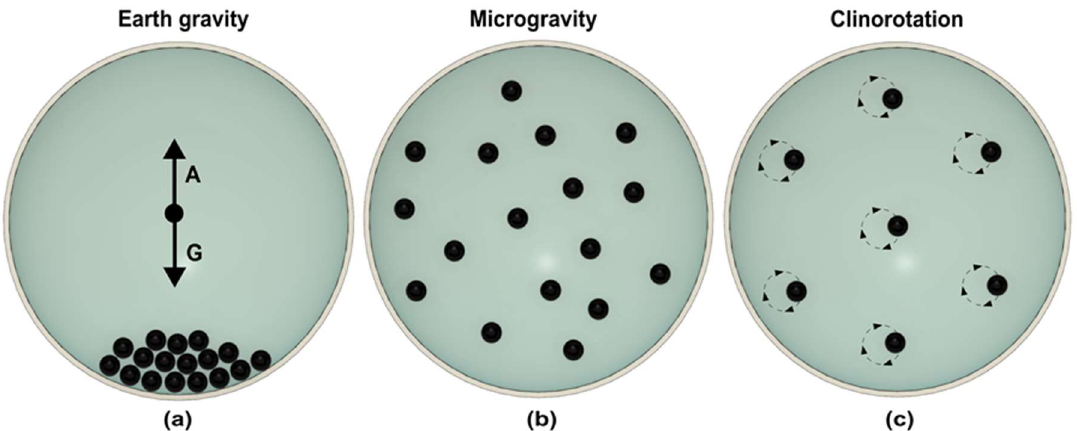
Figure 2. Schematic representation of fast rotating clinostat. ( a ) On earth, particles sediment in the sample holder. The downward gravity (G) and buoyancy (A) forces determine the particle’s position. ( b ) In microgravity, particles are distributed homogeneously due to the lack of gravitational force. ( c ) Fast rotation of sample holder perpendicular to gravity vector generates circular motion of particles. At appropriate speed, no relative circular motion of the particle is visible, generating the same situation as microgravity. (Adapted with permission from [29]. Copyright 2005, Cambridge University Press).